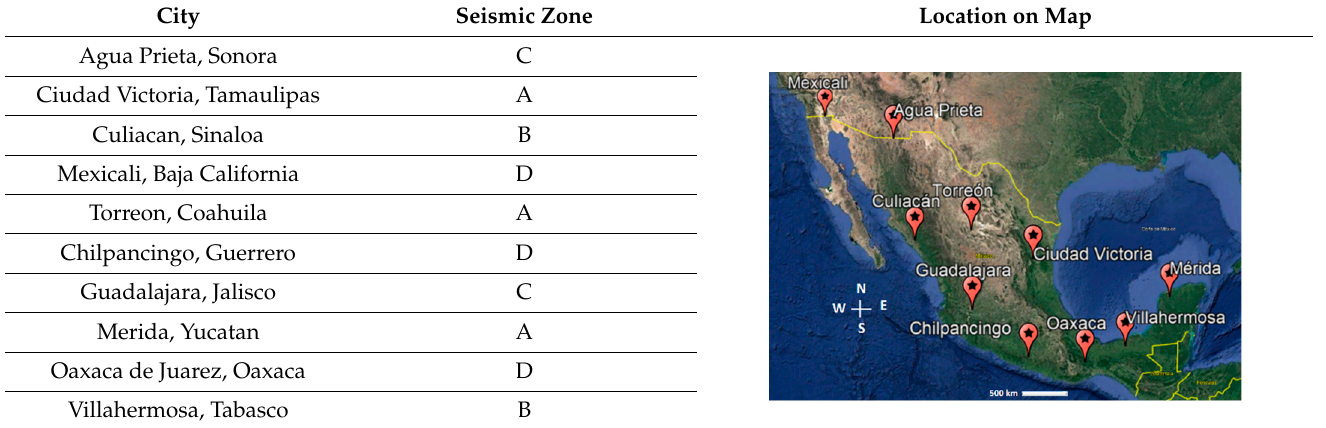
Table 2. Location and corresponding seismic zone of buildings.